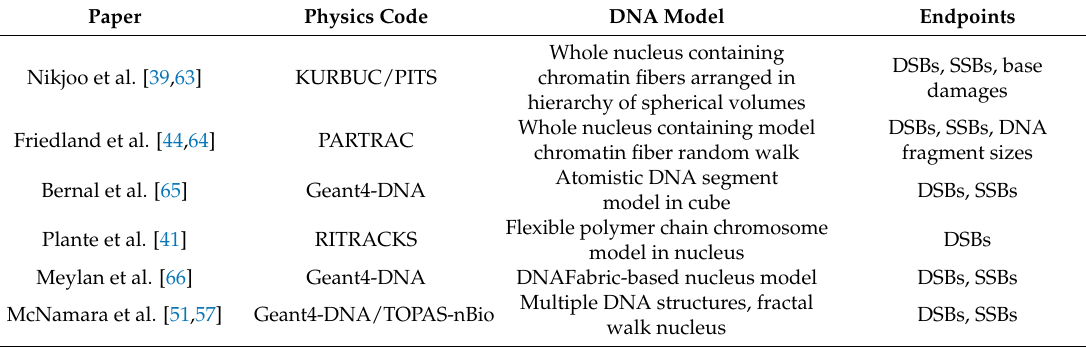
Table 1. List of Monte Carlo models of DNA damage, which combine various track structure physics codes with a variety of DNA models to generate predictions of different classes of DNA damage. A broad range of underlying codes and models have been used to simulate damage from a range of radiation